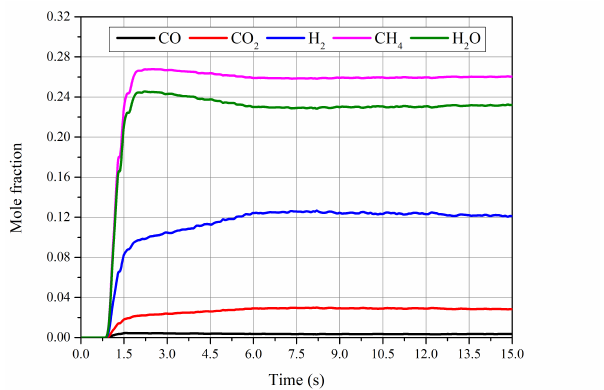
Figure 3. Profile of the time-evolution of the gas species mole fraction at the outlet of the reactor.